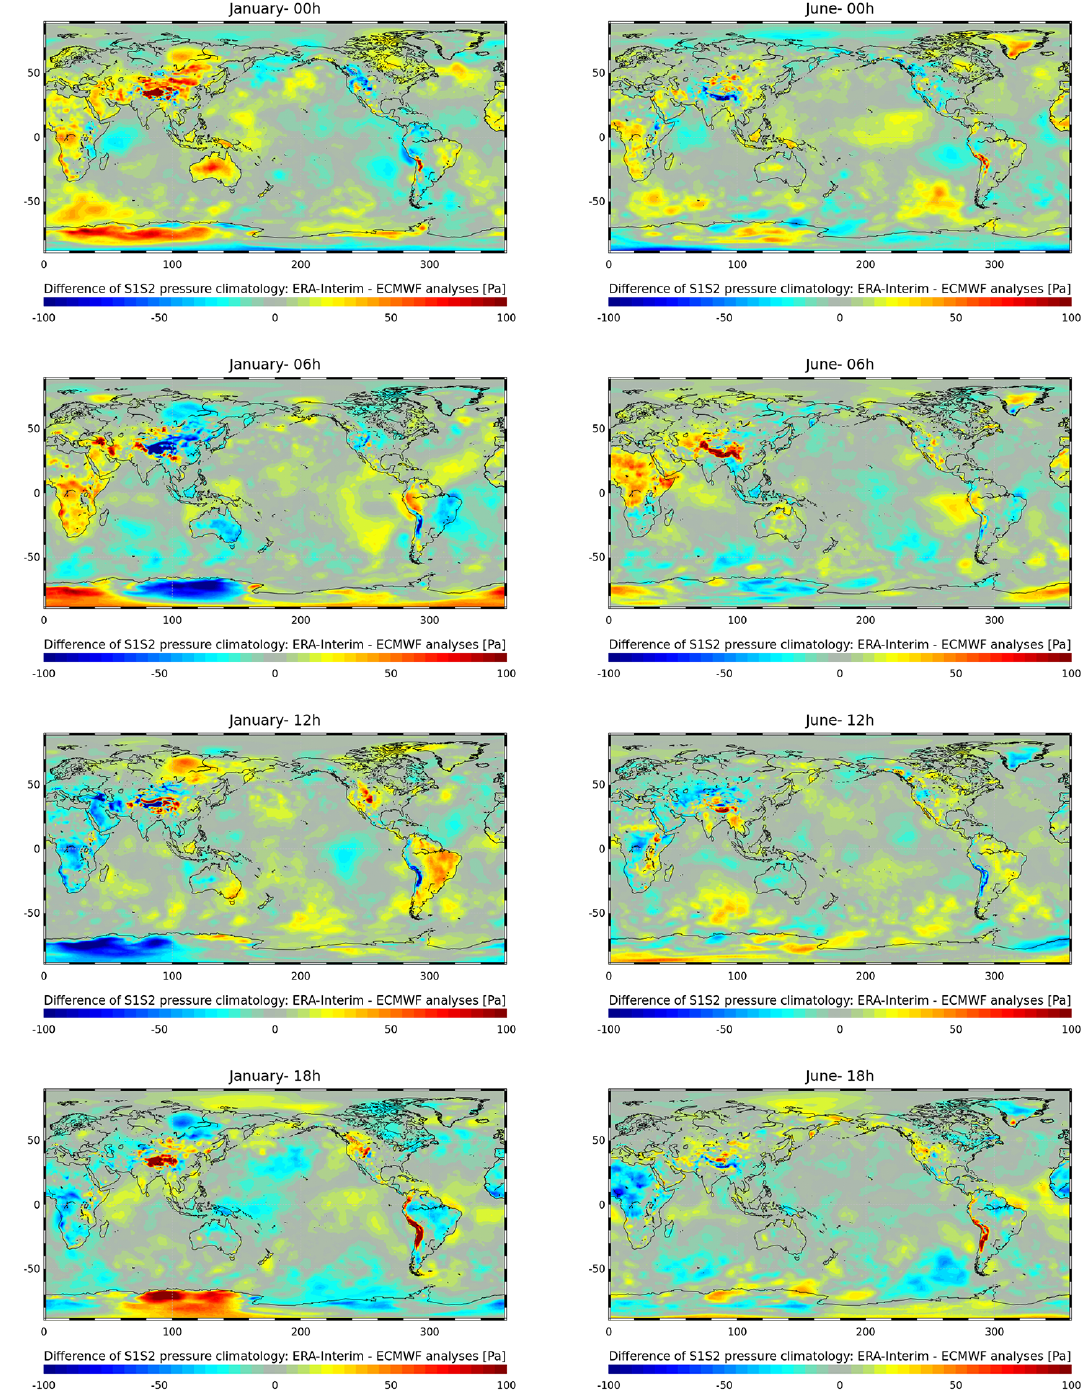
Figure 2. Difference of S1S2 atmospheric pressure climatologies from ERA-Interim and ECMWF analyses, where S1 and S2 represent the diurnal and semidiurnal atmospheric tides,